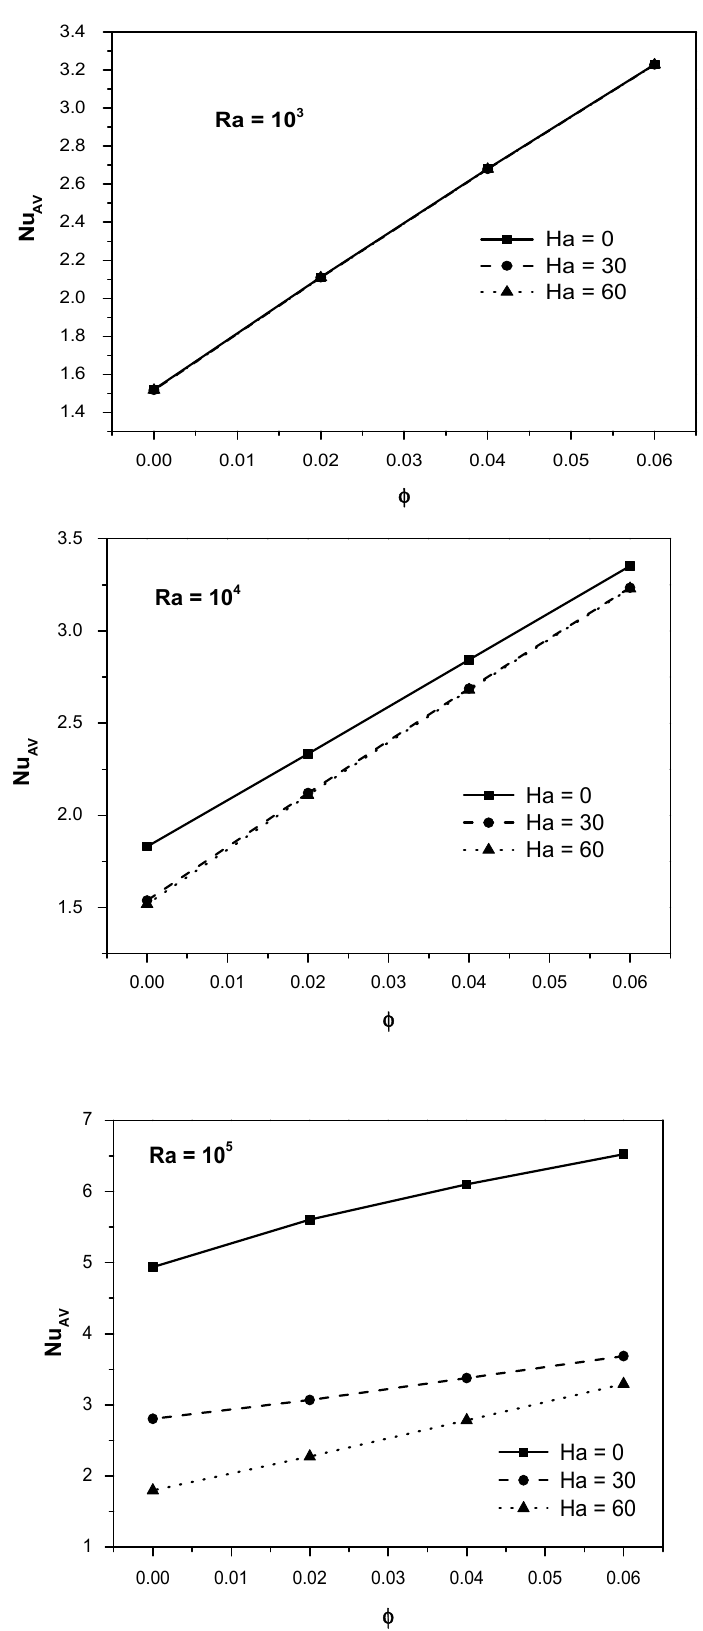
Figure 8. The variation between the average Nusselt number and the solid volume fraction for var- ious values of the Rayleigh number at (d p = 10 nm). The flow structure at (Y-Z) plane and (X = 0.5) inside the cavity filled with pure water [ φ = 0 (solid line)] and Cu-water nanofluid [ φ = 0.04 (dash line)] for various values of (Ra) and (d p ) was presented graphically at Figure 9. In this case, the Hartmann number is con- sidered constant at (Ha = 30).